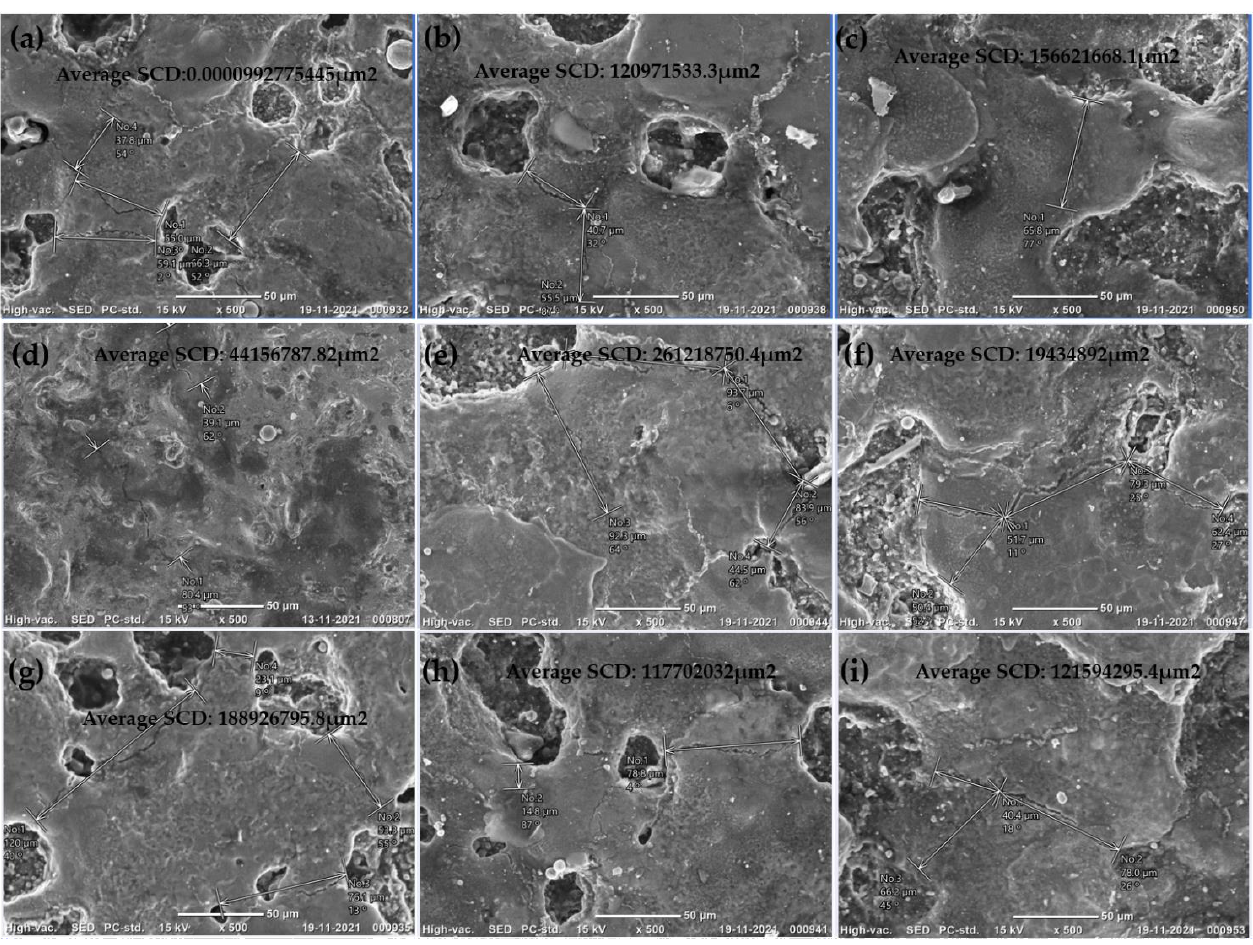
Figure 5. EDC coating Surface with observed microcracks: (a) EX 1, (b) EX 2, (c) EXP 3, (d) EX 4, (e) EX 5 and (f) EX 6, (g) EX 7, (h) EX 8 and (i) EX 9 (all SEM images are 500X)